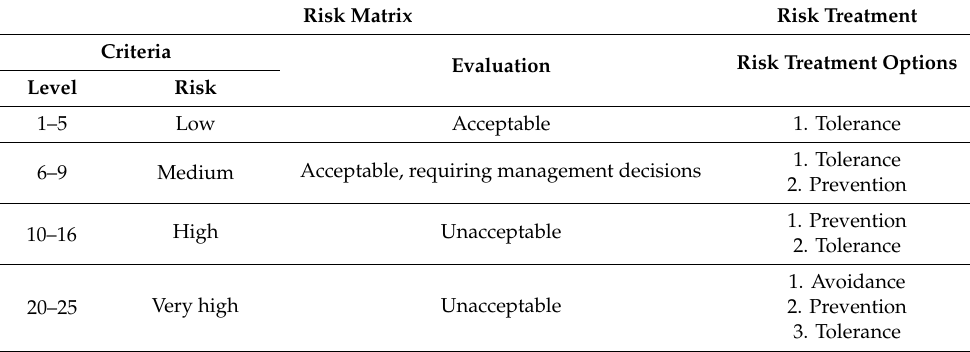
Table 8. Risk matrix and risk